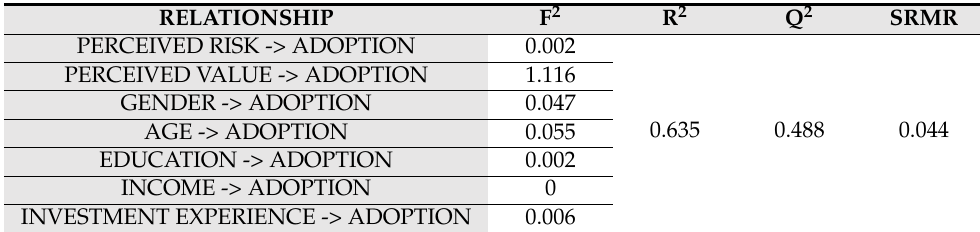
Table 6. F 2 , R 2 , Q 2 , and SRMR results of the structural model